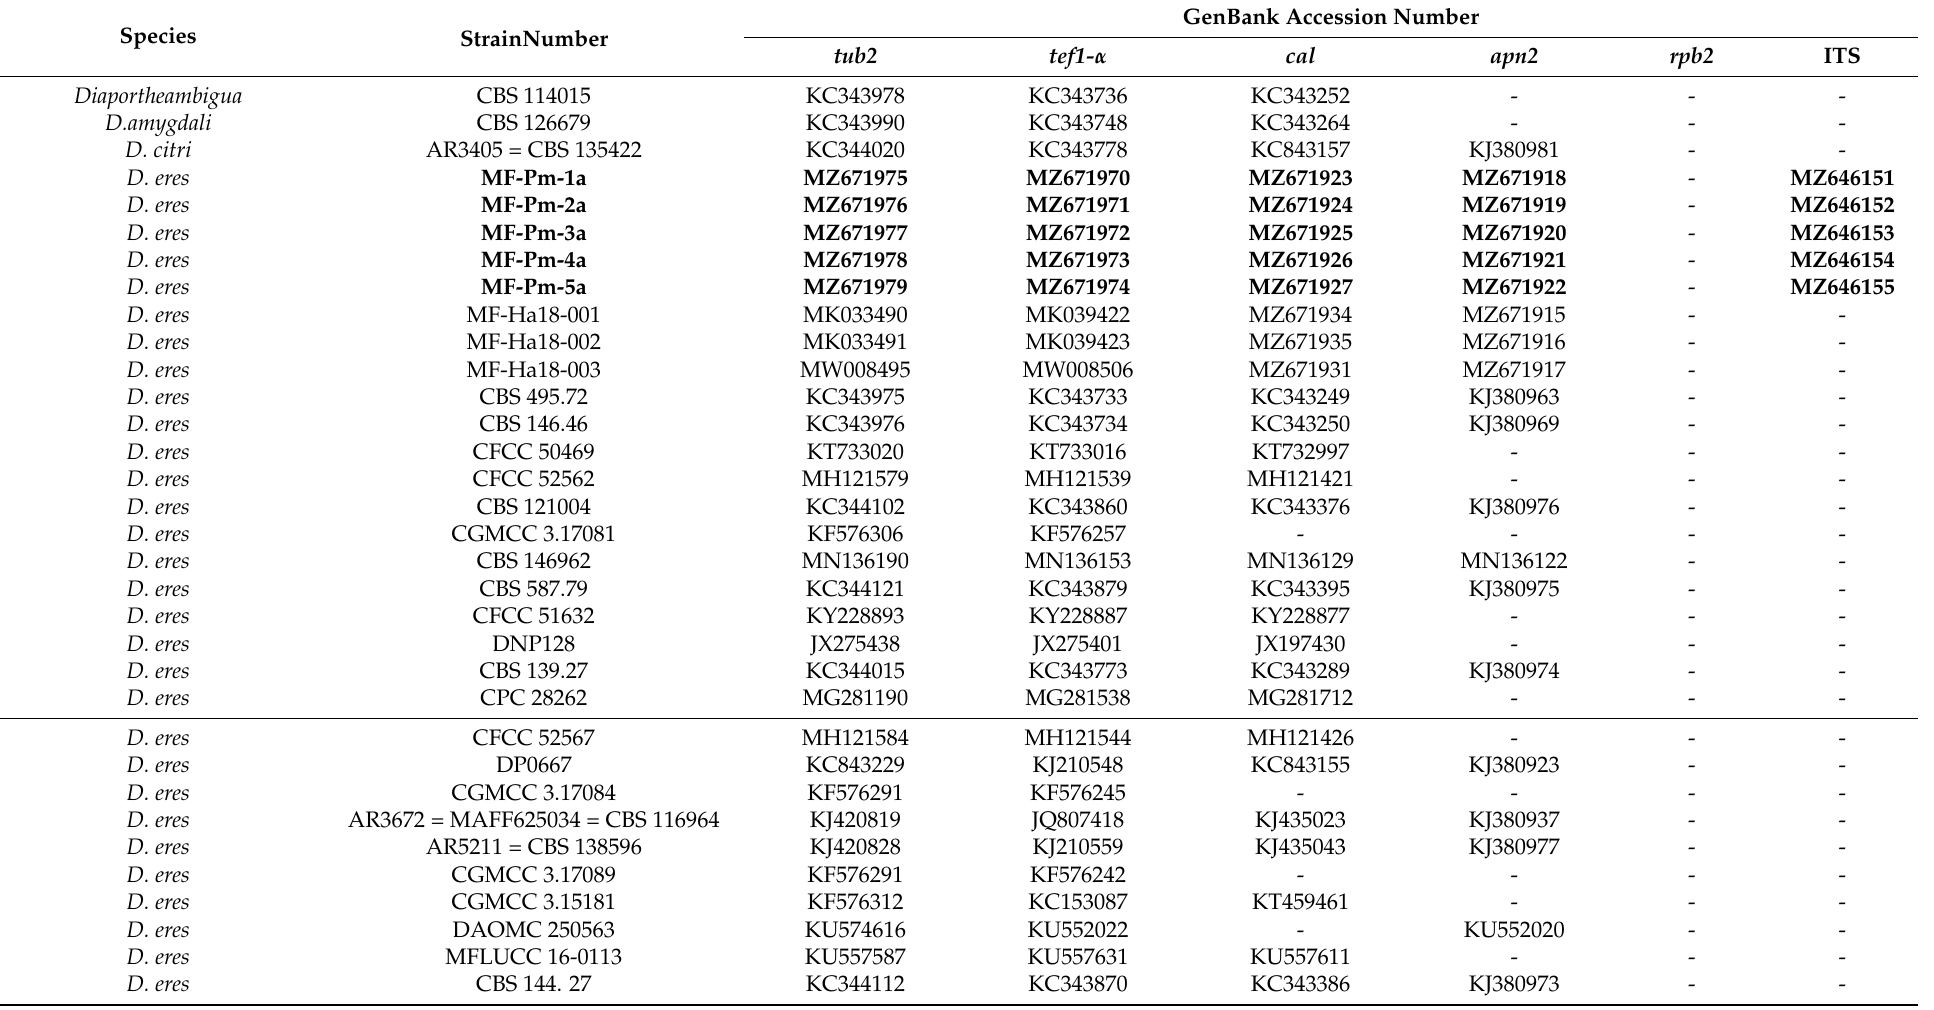
Table 1. List of studied and reference species and